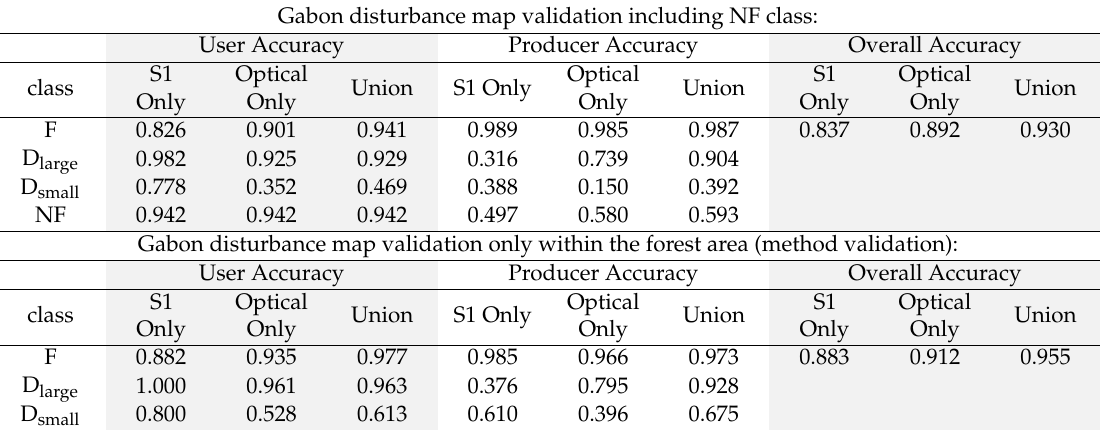
Table 6. Disturbance map validation for